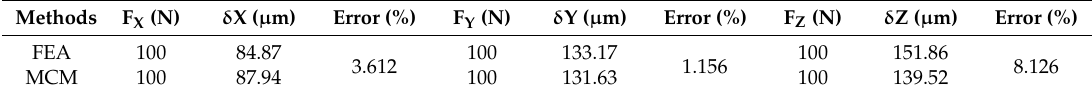
Table 1. The comparison of output compliance.